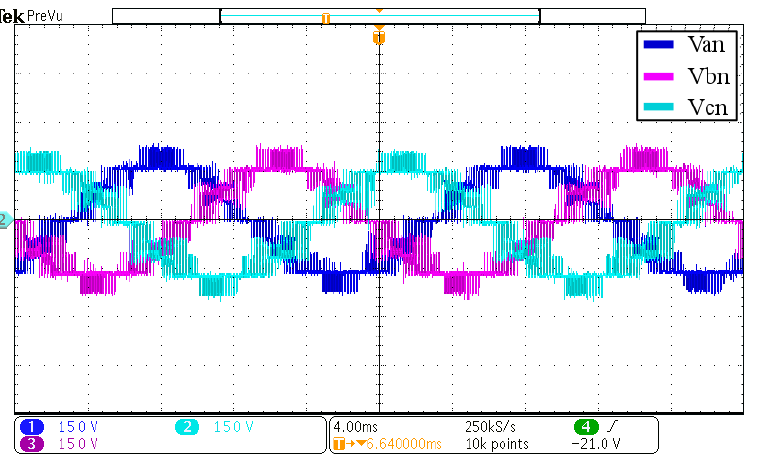
Figure 20. Experimental waveform of AHMMC output phase voltages at M f = 1 tracing channels 1, 2, 3 (150 V/div).